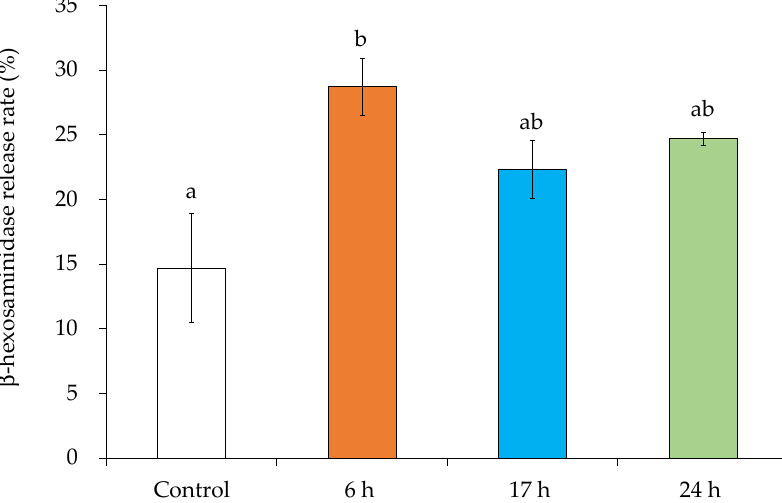
Figure 7. β -Hexosaminidase release induced by membrane vesicles (MVs) obtained from supernatants with different incubation times. MVs were exposed to IgE sensitized rat basophilic leukemia (RBL-2H3) cells for 1 h, followed by a β -hexosaminidase-release assay. Significant letters represent significant differences (Tukey–Kramer test, p < 0.05). Values represent the mean ± SD of three independent experiments.